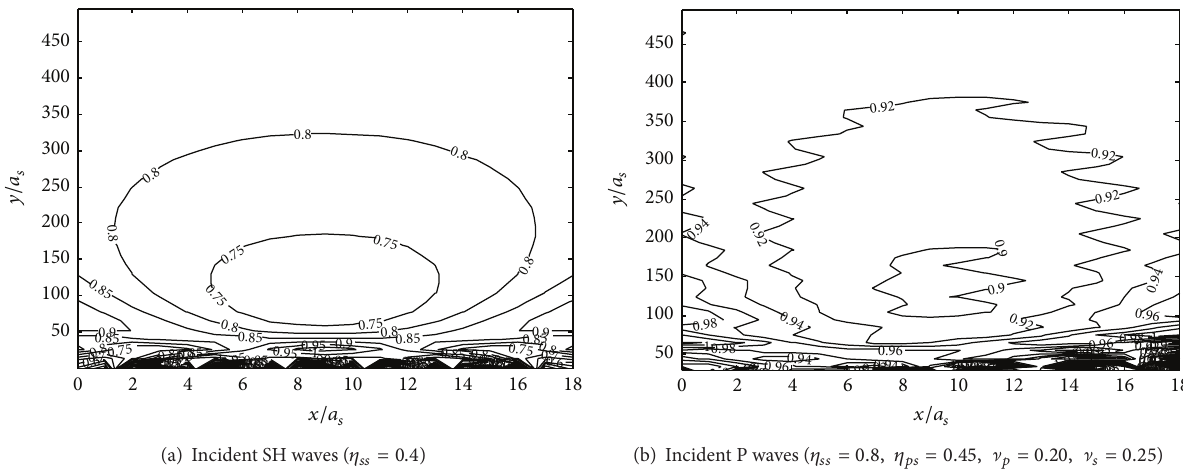
(b) Incident P waves ( 𝜂 𝑠𝑠 = 0.8, 𝜂 𝑝𝑠 = 0.45, ] 𝑝 = 0.20, ] 𝑠 = 0.25 )